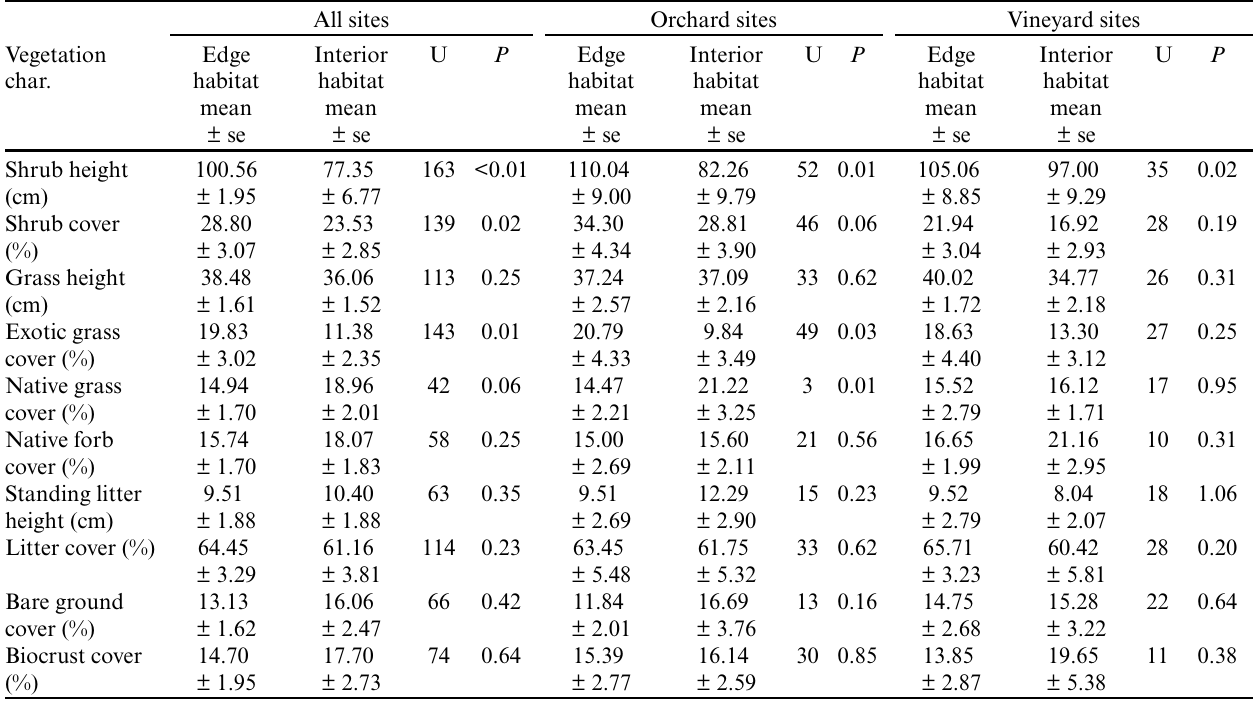
Table 2 . Local vegetation characteristics in edge and interior sagebrush habitat. Edge habitat was located adjacent to vineyard (n = 8) or orchard (n = 10). All sites indicates orchard and vineyard sites pooled. Differences between edge and interior sites were tested with paired Wilcoxon rank sign